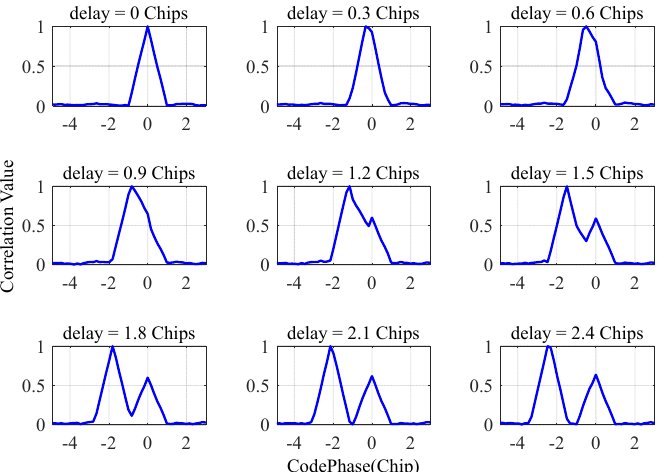
Figure 7. The effect of spoofing interference on correlation peaks.